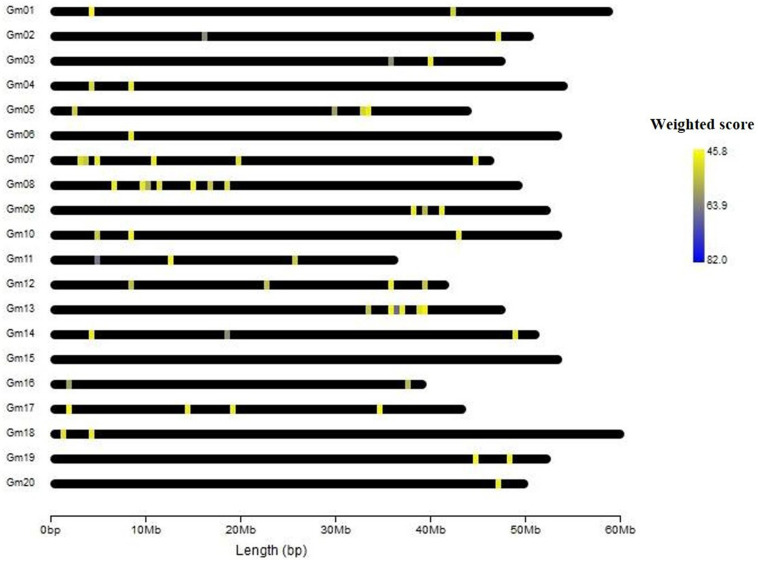
The location of 83 FTgenes on soybean genome map.